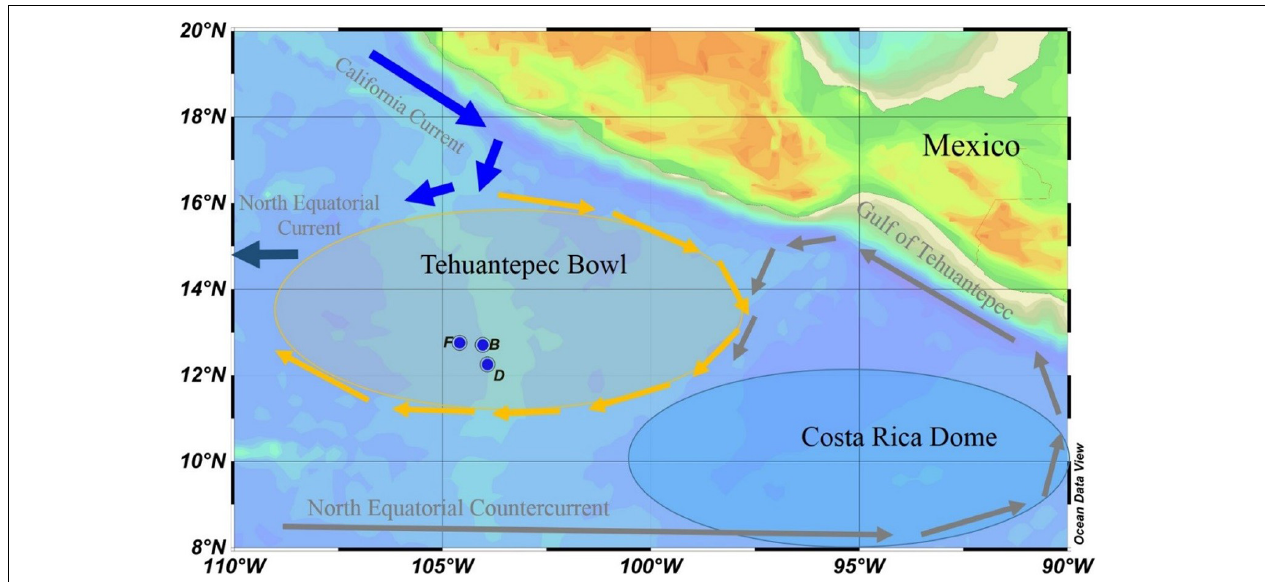
FIGURE 1 | Sampling locations in the eastern tropical North Pacific. The Tehuantepec Bowl is a warm core ring, and the Costa Rica Dome is a cold core ring. Currents are represented in gray fonts, and arrows of different colors indicate the general direction of the currents.